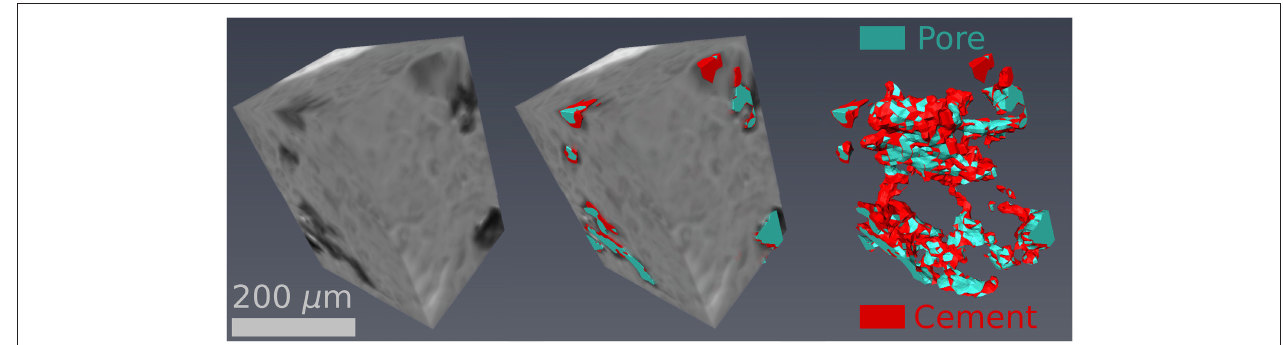
FIGURE 8 | 3D visualization of gray scale and segmented images of a subvolume in the Knorringfjellet sandstone. The micrograph in the middle overlaps the gray scale image on the segmented phases, whereas the micrograph on the right shows only the macropore and the microporous cement.